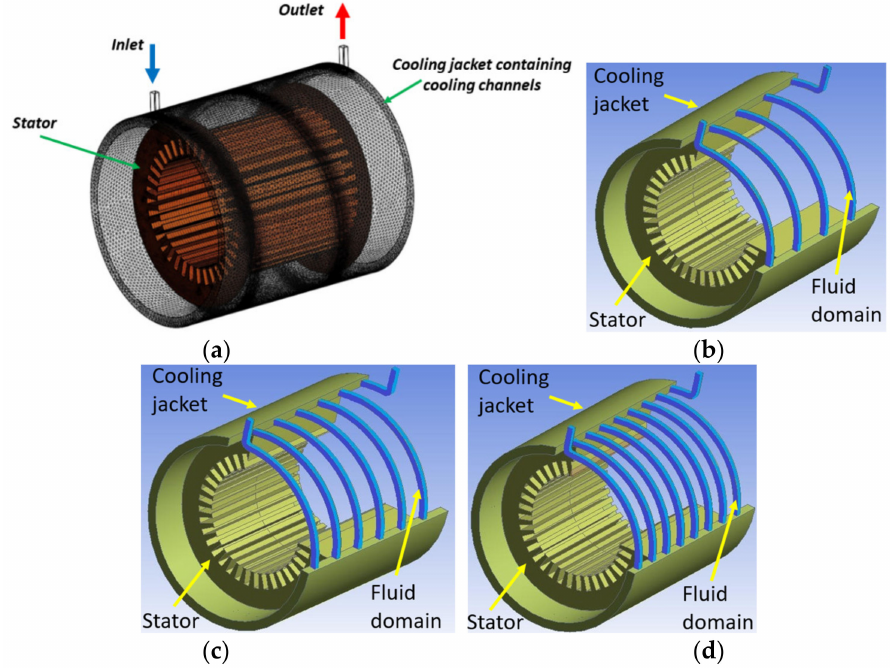
Figure 1. Schematic of the cooling system: ( a ) meshed, and with ( b ) 4 channel turns, ( c ) 6 channel turns, and ( d ) 8 channel